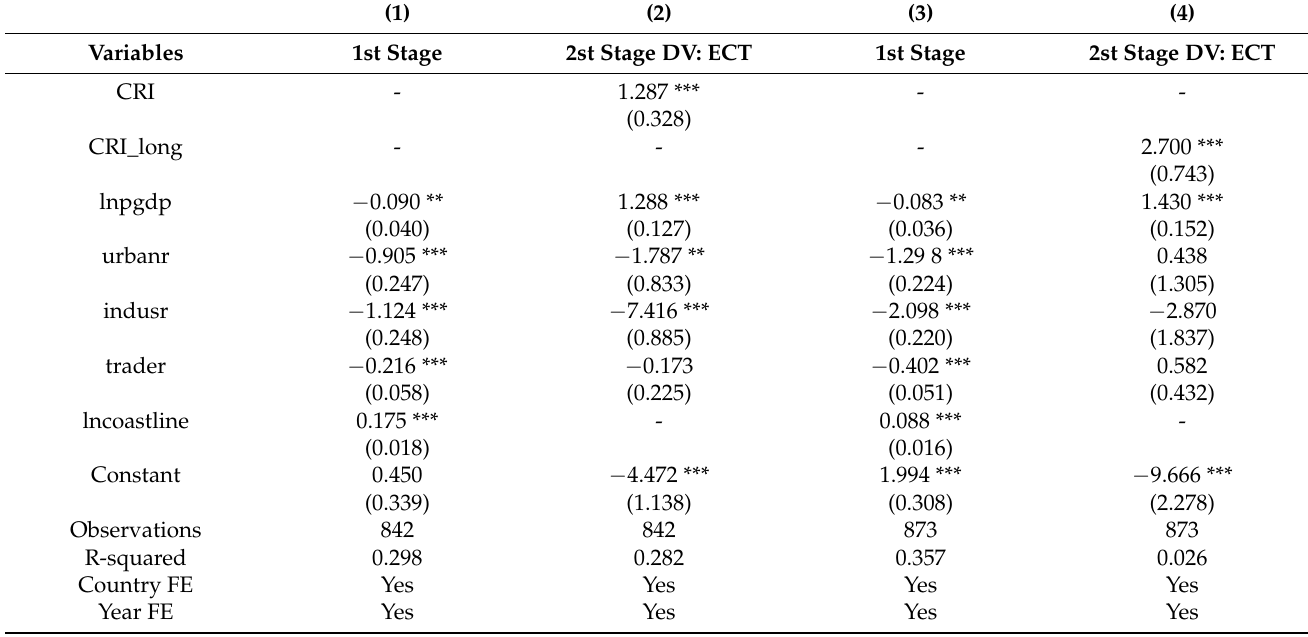
Table 7. Estimation results of the endogeneity